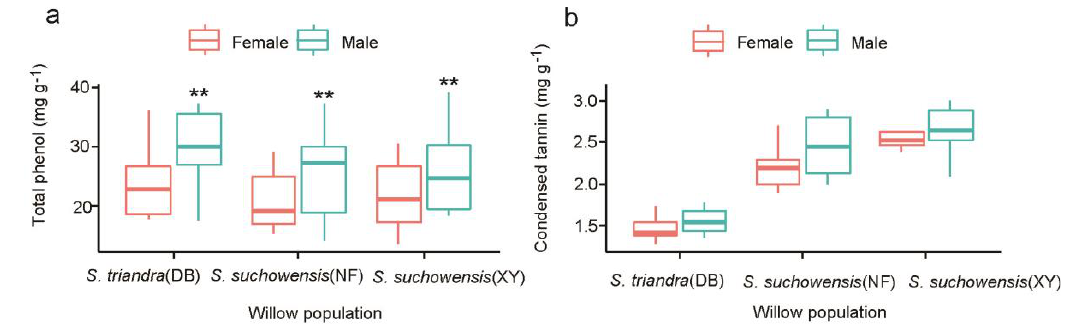
Figure 2. Contents of defensive substances in leaves of willow plants. ( a ) Total phenol content in willow leaves. ( b ) Content of condensed tannin in willow leaves. Notes: Comparisons between females and males within total phenol (TP) and condensed tannin (CT) were performed using the pairwise t-test. ** p < 0.01.